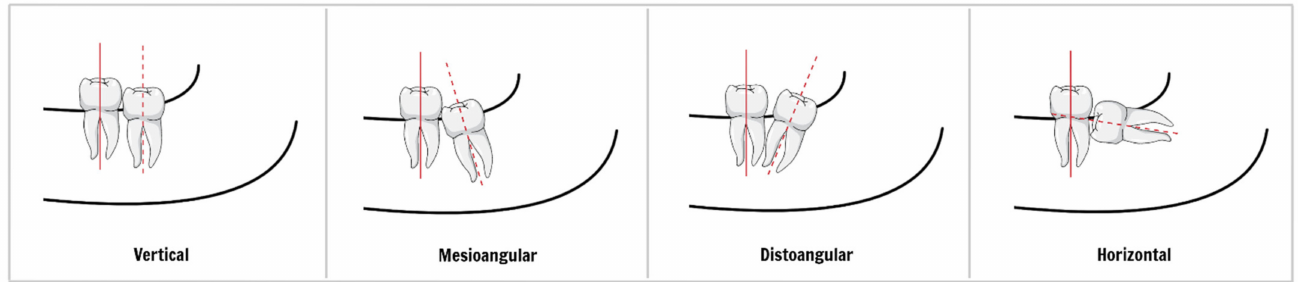
Figure 3. Winters’s classification. The classification is based on the inclination of the impacted wisdom tooth (third molar) to the long axis of the second